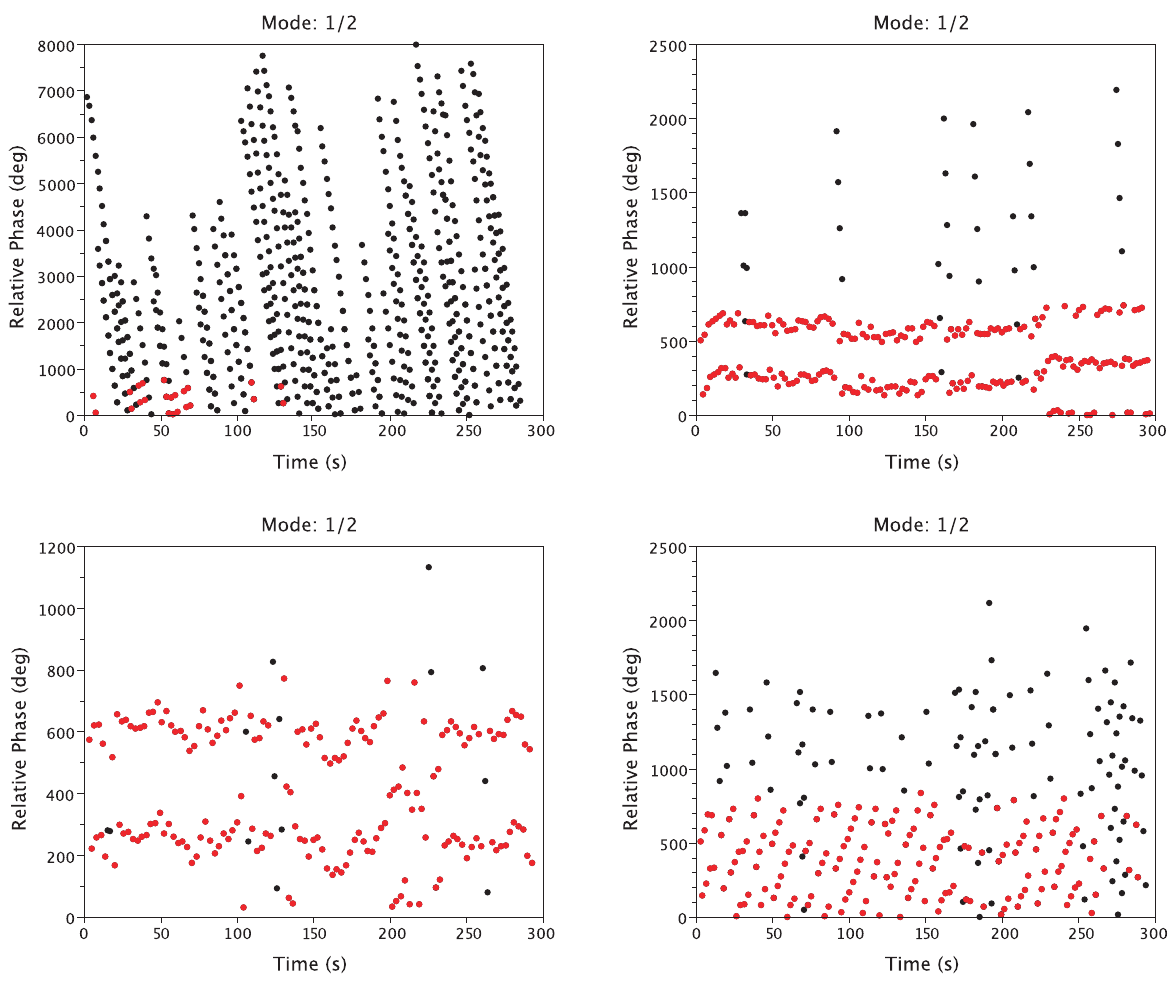
Figure 5. LRC variables for two representative participants in the RESP condition. The left two panels represent three minutes of relative phases for subject S05 (Sound-off at the top and Sound-On at the bottom). The right two panels represent three minutes of relative phases for subject S15. Red dotes represent the relative phase values for the modal frequency ratio and black dotes represent the relative phase values for the other expressed frequency ratios.